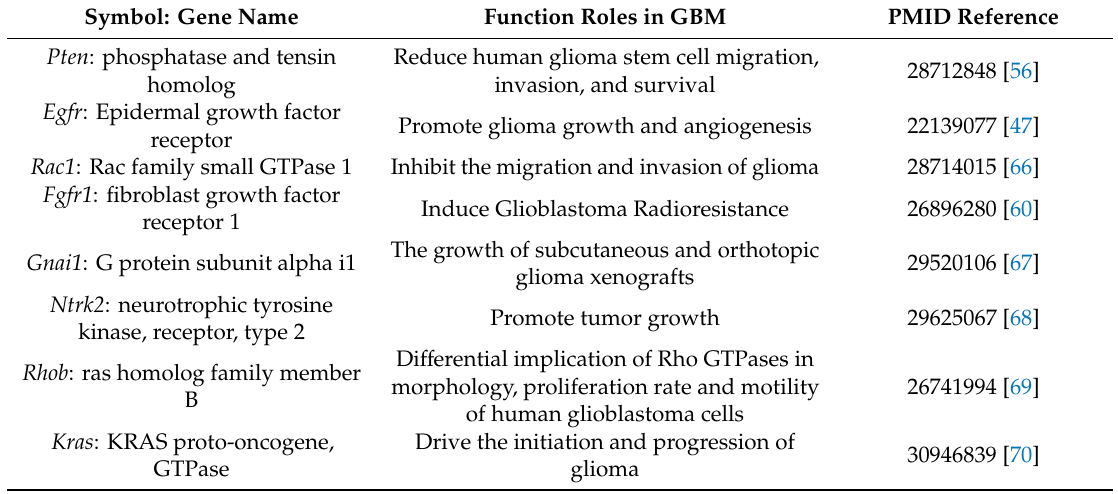
Table 6. The biological functions, corresponding PubMed IDs and literature references for enriched genes by GO enrichment analyses between aNSC and NPC.